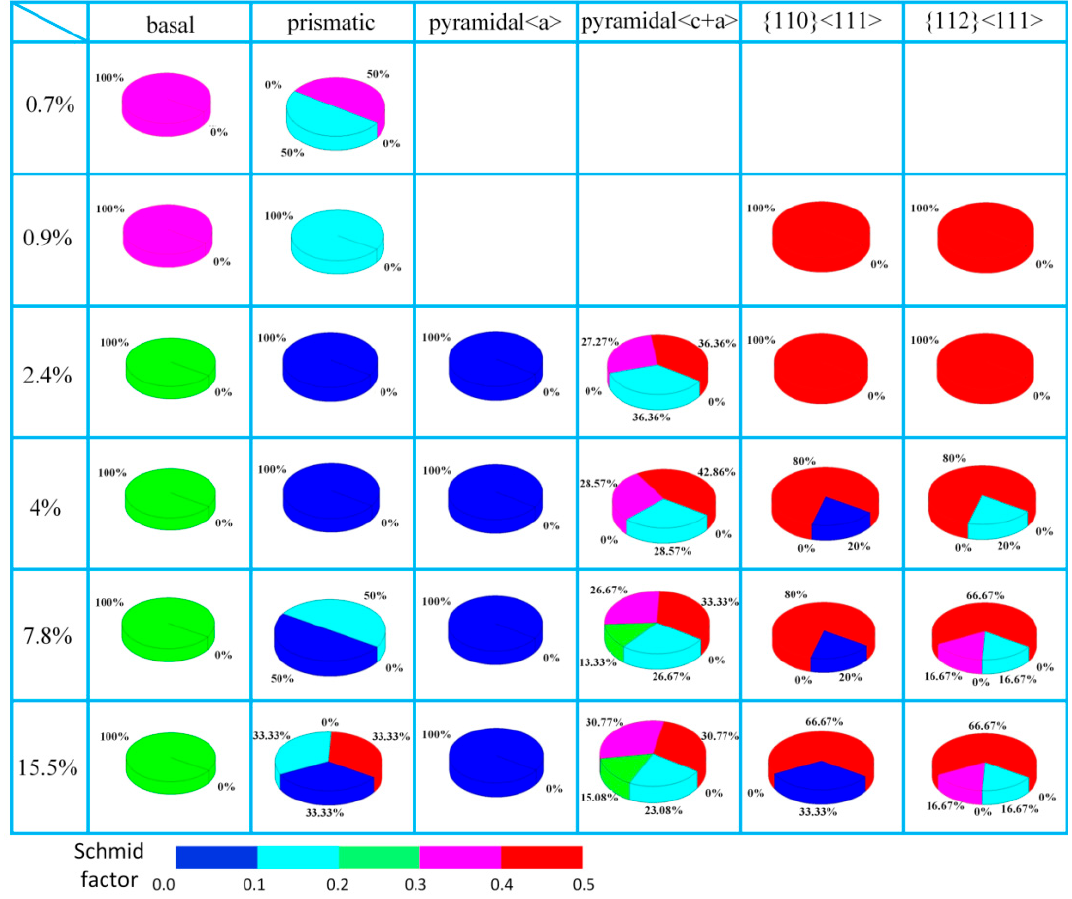
= 0.7%, 0.9%, 2.4%, 4.0%, 7.8%,